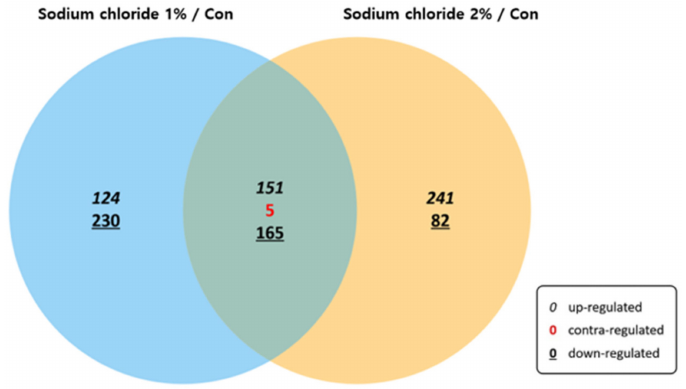
Figure 2. Venn diagram analysis of Pleurotus ostreatus by NaCl concentration. Table 4. Gene list of Pleurotus ostreatus by different NaCl concentrations.